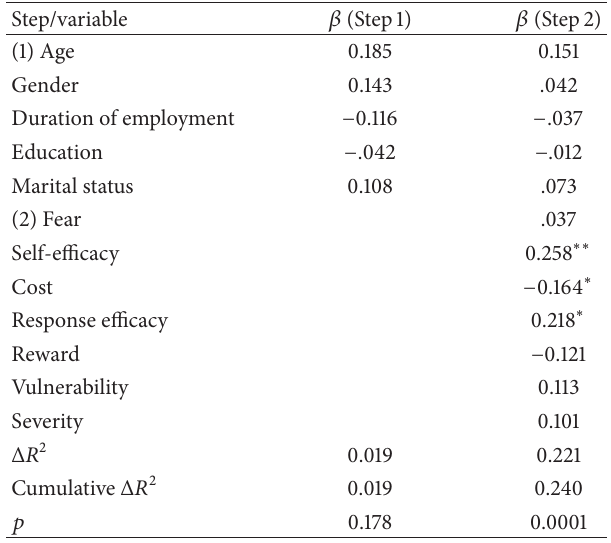
Table 7: Predicting cancer preventive behaviors: hierarchical regression analysis ( 𝑁 = 161